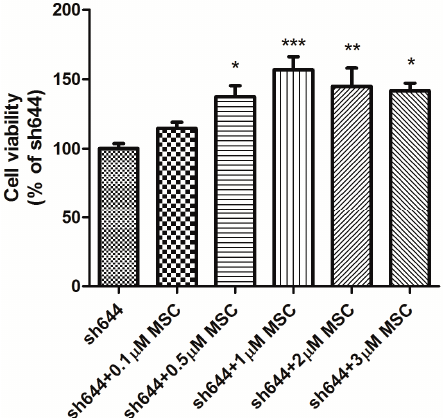
Figure 5. Dose-dependent effect of Se-methylselenocysteine (MSC) on the viability of Clu -knockdown N2a cells. Cells transfected with the plasmid pGPU– Clu –mus–sh644 (sh644) were used as the control. * p < 0.05, ** p < 0.01 and *** p < 0.001 vs. the control.